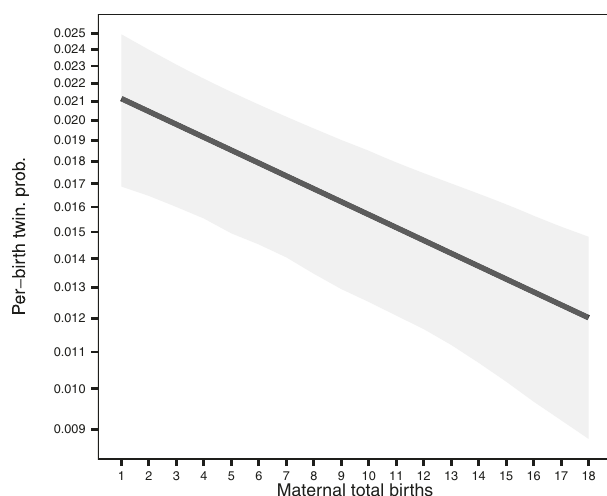
Fig. 2 Relationship between per-birth twinning probability and maternal total births. This plot shows marginal predictions (line) ± CI 95% (grey area) from the fi t of a generalised linear mixed-effects model including maternal total births as fi xed effect and variation between populations as a random effect ( n = 21,290 mothers in total, from 8 populations; see Table 1). Estimates obtained for per-birth twinning probability vary between 0.021 (CI 95% : 0.017, 0.025) for mothers who gave birth only once, and